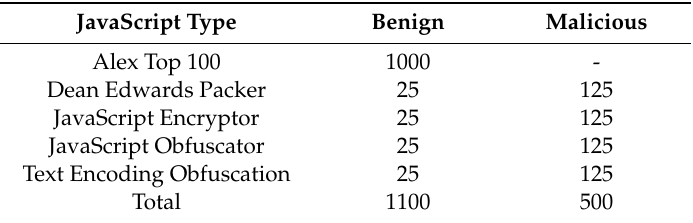
Table 3. JavaScript type and dataset